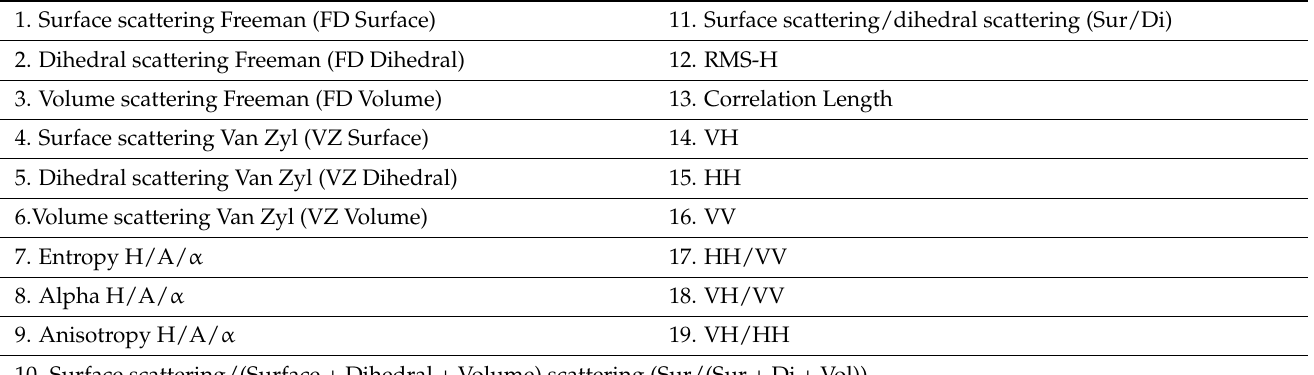
Table 5. The features used as input for soil moisture